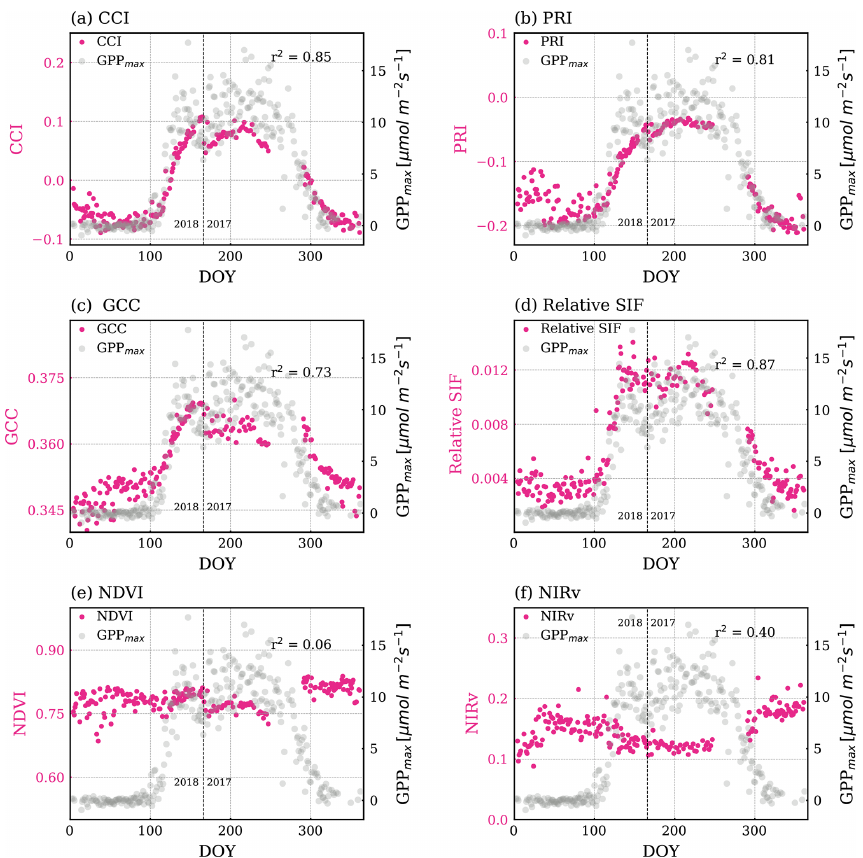
Figure 5. Magenta points are time series of VIs: (a) CCI, (b) PRI, (c) GCC, (d) relative SIF, (e) NDVI, (f) NIRv. The grey points in the background show GPP max . The Pearson r 2 values of regressing VIs and GPP max are noted in each plot. The p values of all correlations in this figure are less than 0.005. The vertical dashed line divides the observations from DOY for the years 2017 and